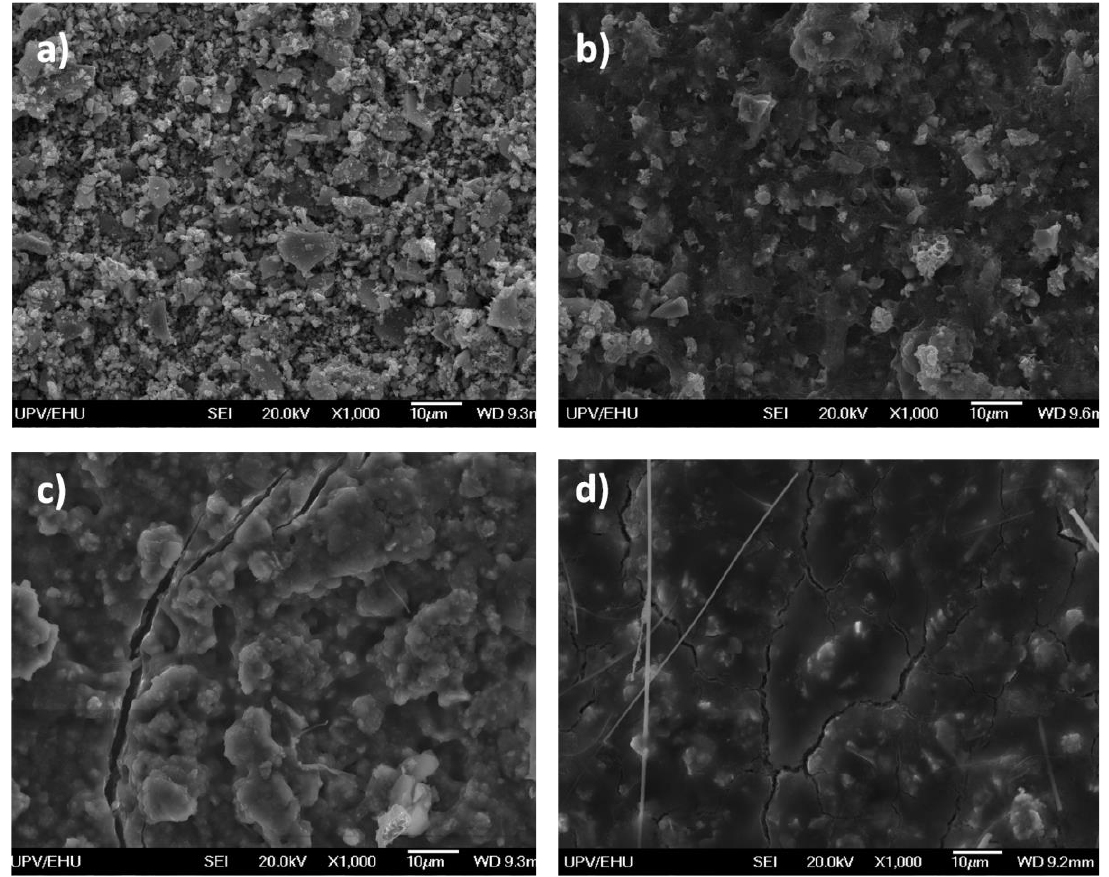
Figure 7. SEM micrographs of NiO_29%C powder ( a ) laminate ( b ) and the discharged ( c ) and charged ( d ) electrodes.